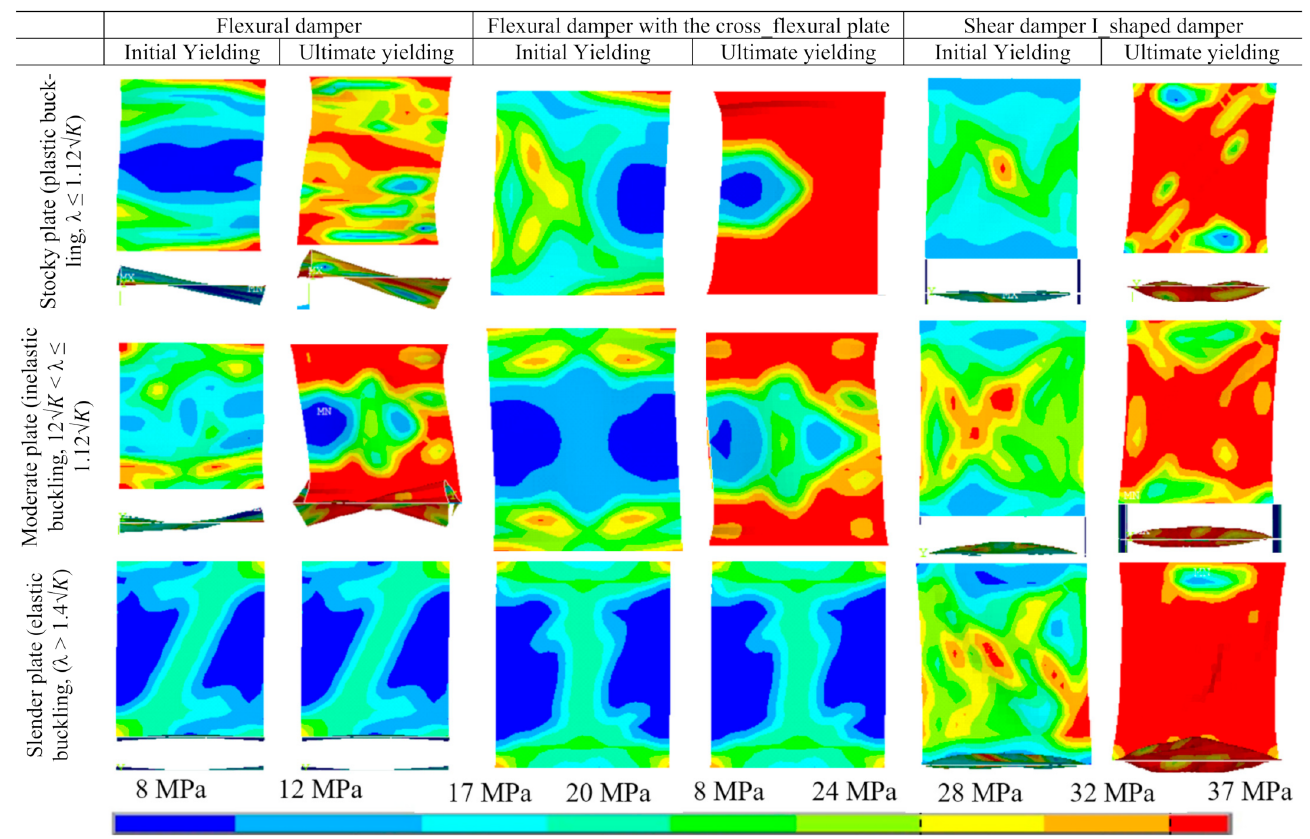
Figure 11. The yielding status in the plates of the